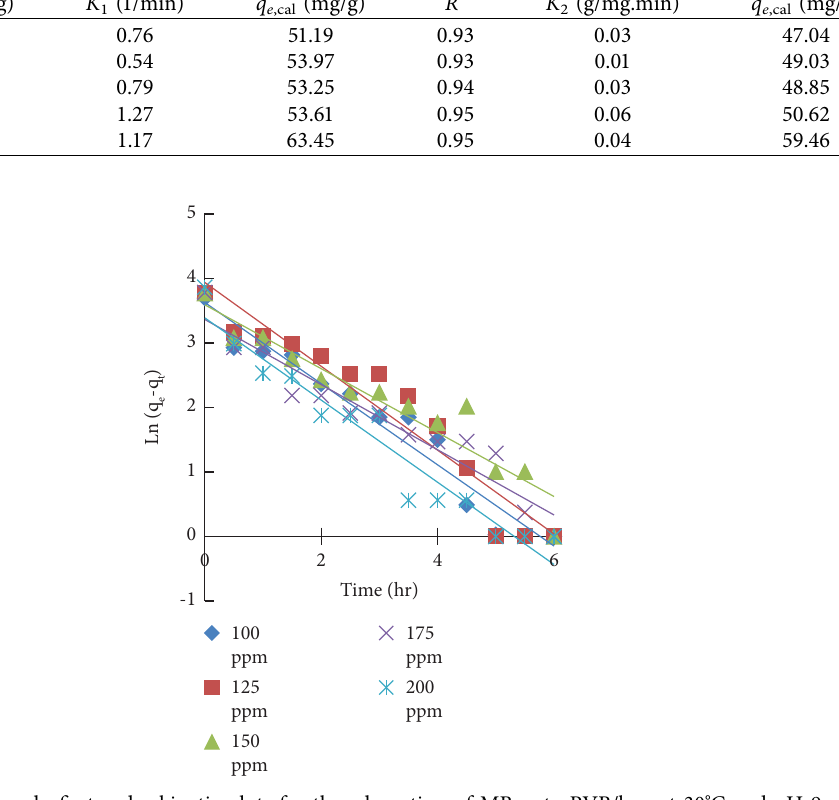
Figure 13: Pseudo-frst-order kinetic plots for the adsorption of MB onto PVB/ben at 30 ° C and pH 9.